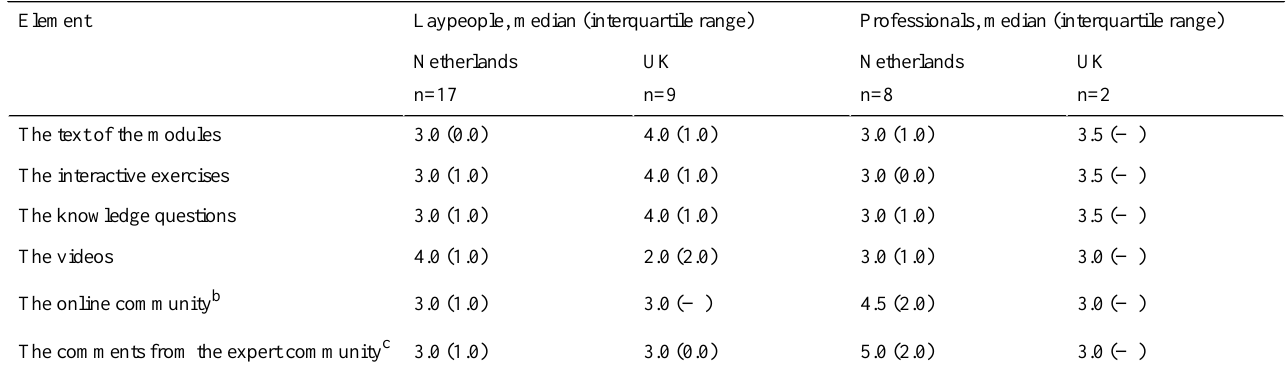
Table 3. Ratings on usefulness of specific elements of the STAR training (range 1-4). a